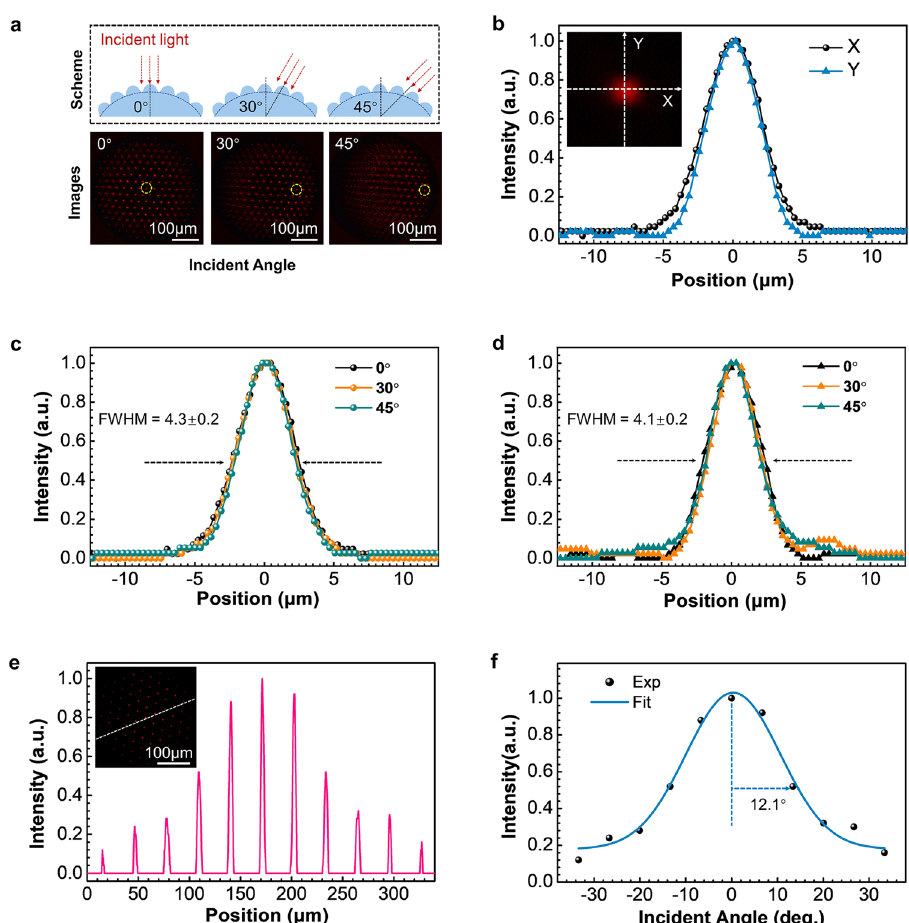
Fig. 3 | Measurement of FOV and angular sensitivity function (ASF) of the logarithmic μ -CE. a Schematic illustration(top)and the focused light fi eldimages (bottom) of the logarithmic μ -CE; the incident angles are 0°, 30°, and 45°, respectively. b Comparisonoftheintensitydistributionsalongthe X -axisand Y -axis atnormalincidence;theinsertisanimageofafocalpoint. c , d Normalizedintensity